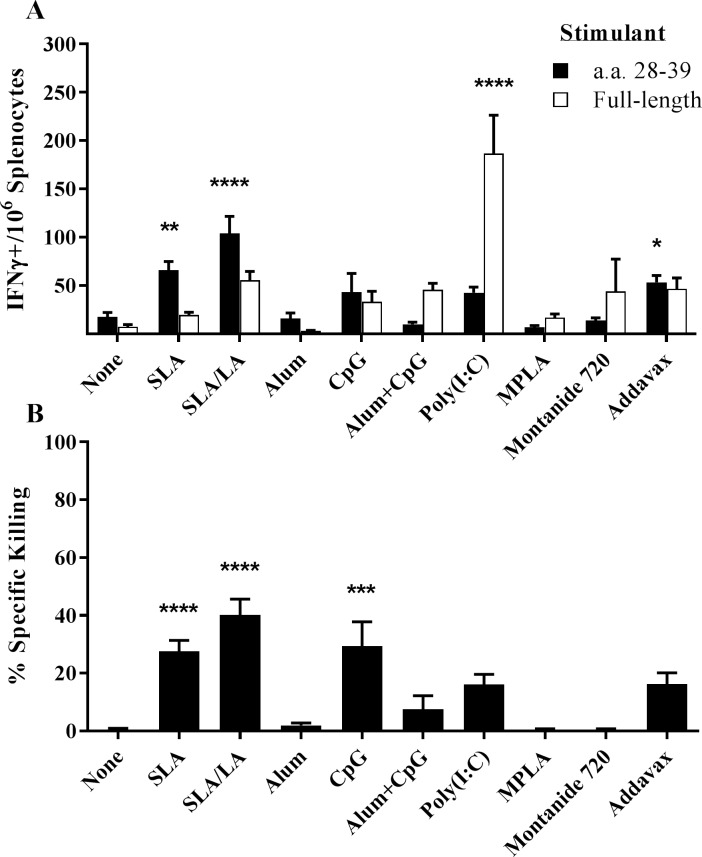
HBsAg-specific cellular immune responses in immunized mice.BALB/c mice (n = 10/group) were injected i.m. on Days 0 and 21 with HBsAg (2 μg) with or without adjuvant. Splenocytes were harvested on Day 28 and analyzed by IFN-γ ELISpot when stimulated by an HBsAg-specific peptide or full-length protein (Panel A). In addition, the in vivo cytolytic activity of HBsAg-specific CD8+ cells was assessed by the measurement of CFSE-labeled target cells in the splenocytes collected on Day 28 (Panel B). Grouped data is presented as mean + standard error of mean (SEM). *: p<0.05, **: p<0.01, ***: p<0.001 & ****: p<0.0001 for various groups receiving adjuvanted formulations when compared to unadjuvanted control group by one-way ANOVA followed by Dunnett's multiple comparisons test.